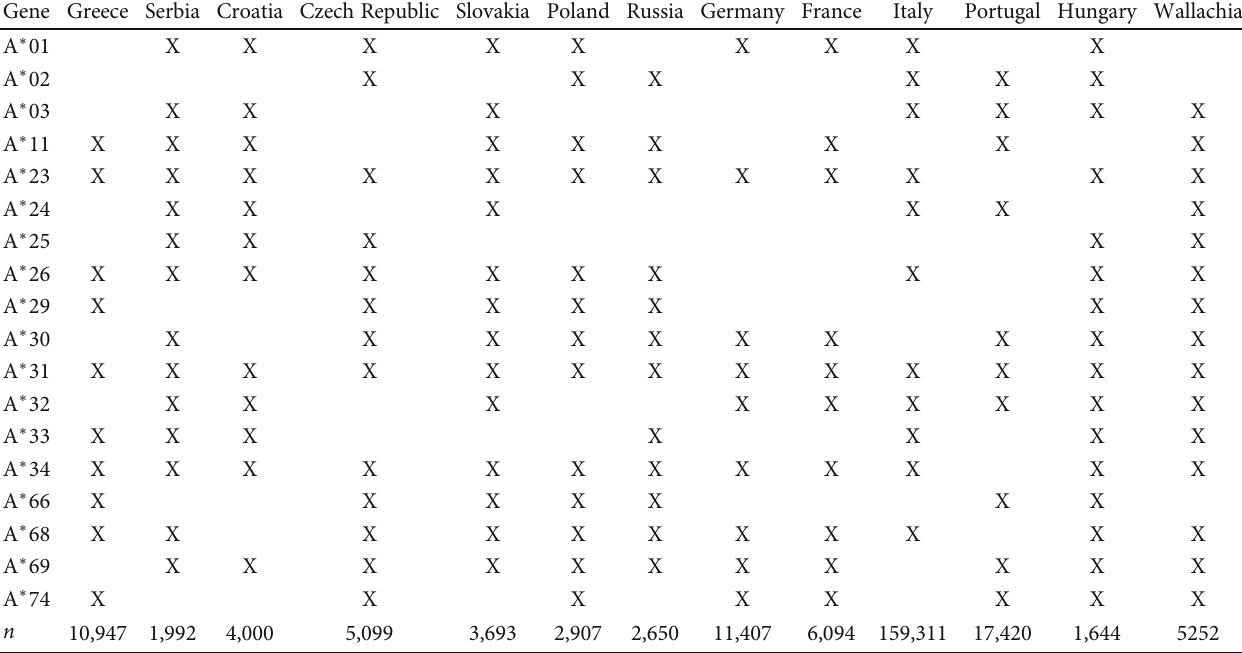
Table 4: Comparison of HLA-A gene frequencies in the Transylvanian ( n = 2,794 ) vs. other European population